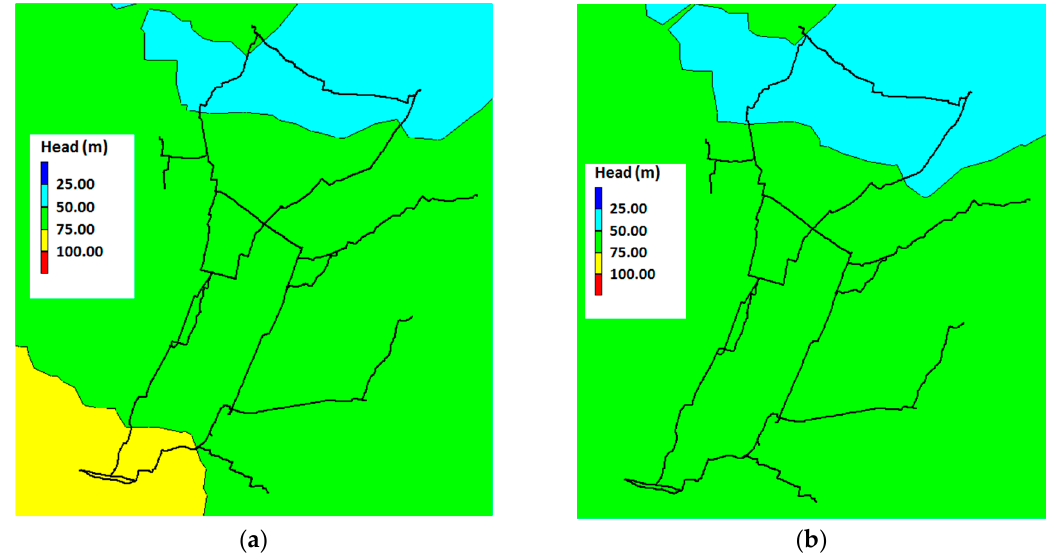
Figure 6. Contour plots of the total head over Roncocesi and Luzzara networks. ( a ) Total head at 10 a.m. ( b ) Total head at 8 p.m.